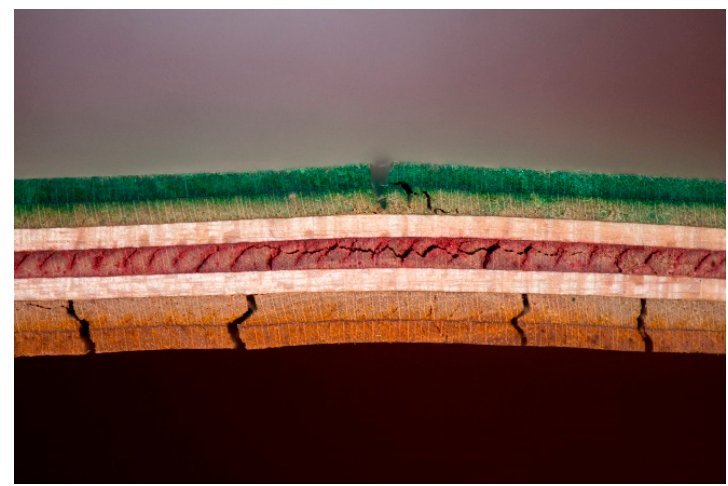
Figure 18. Cross Section View Showing Splitting in Sample 3.